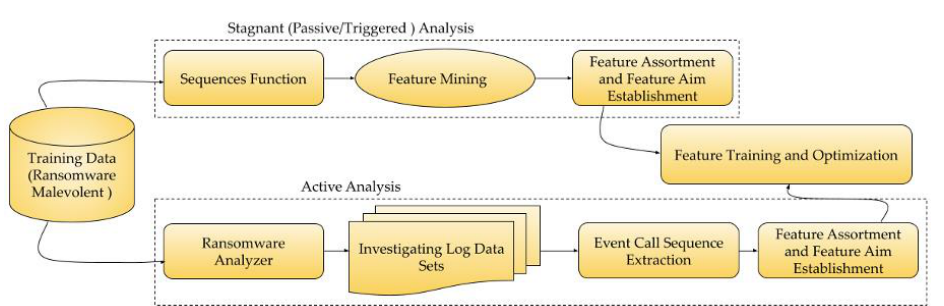
Figure 4. Ransomware’s Feature detection and Optimization Process. Figure 5 indicates the mean latency, which is logged and compared after the detection technique has been carried out to determine whether the performance of other transactions is stimulated by the applied detection approach. In terms of performance measurement after